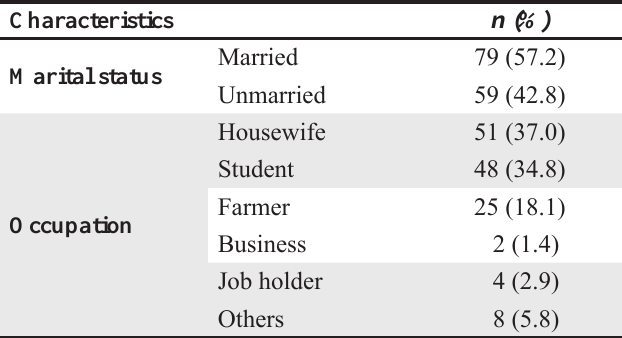
Table 1 : Marital status and occupation of the patients of poisoning (N = 138)